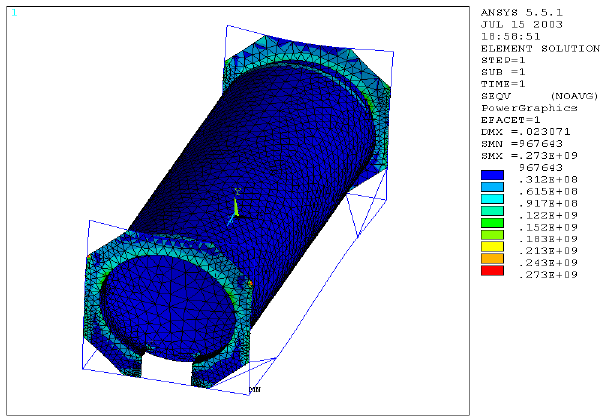
Figure 17. Equivalent stress (Von Mises).